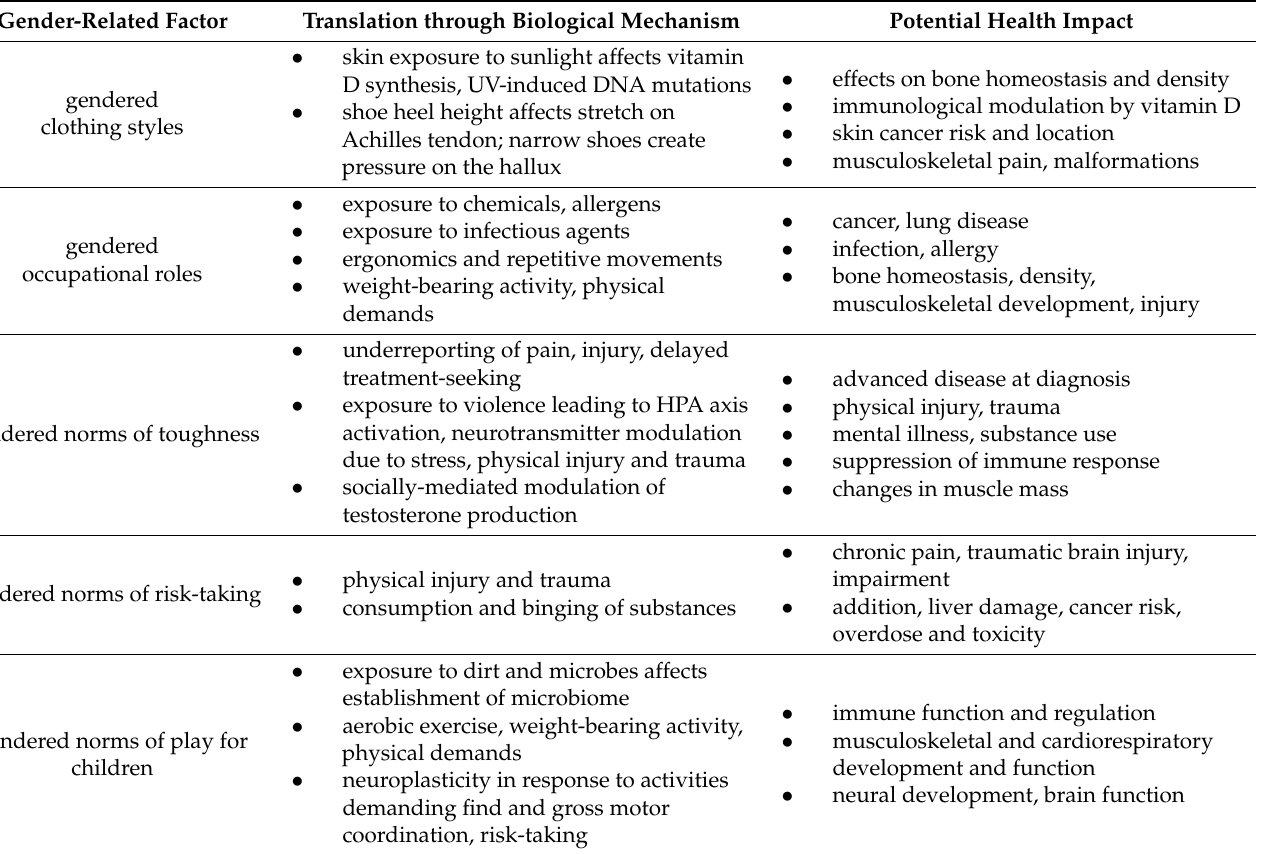
Table 2. The translation of gender-related factors through biological mechanisms to health